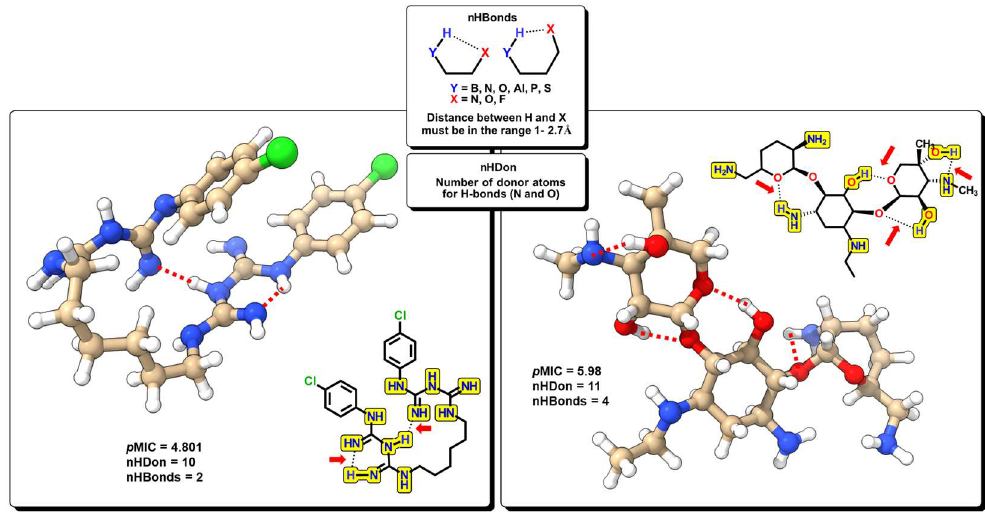
Figure 10. Functional-group count (FGC) descriptors with some representative molecules for nHDon and nHBonds. Highlighted in yellow are groups for which hydrogen donor atoms are counted (nHDon). Red arrows indicate the groups where intramolecular hydrogen bonds are pos- sible (nHBonds).